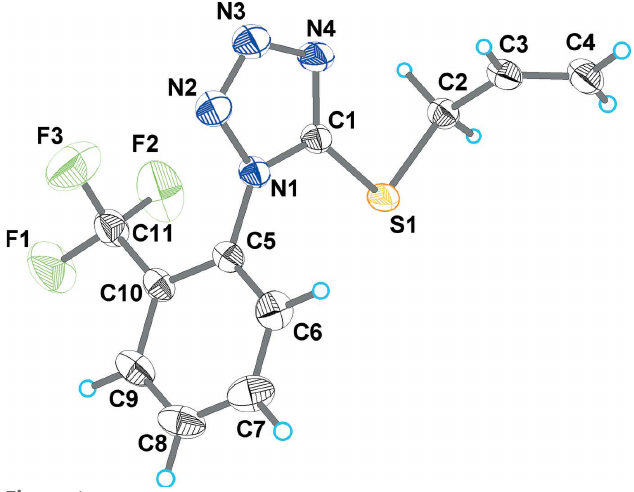
Figure 1 The molecular structure of (I) with displacement ellipsoids drawn at the 50% probability level.